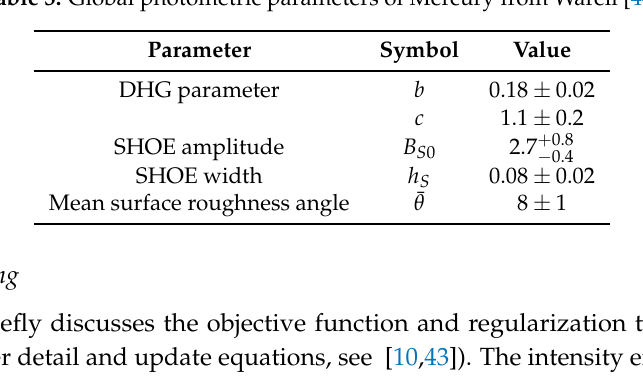
Table 3. Global photometric parameters of Mercury from Warell